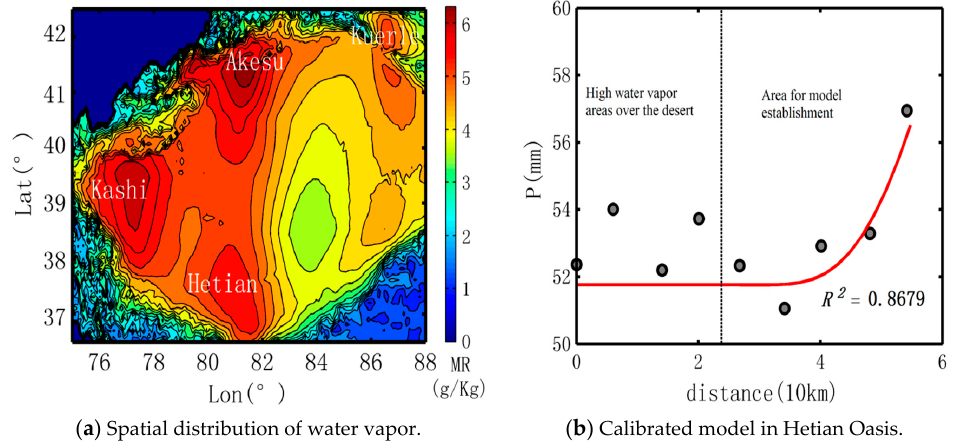
Figure 6. Spatial distributions of water vapor in Tarim Basin and the calibrated model in Hetian.